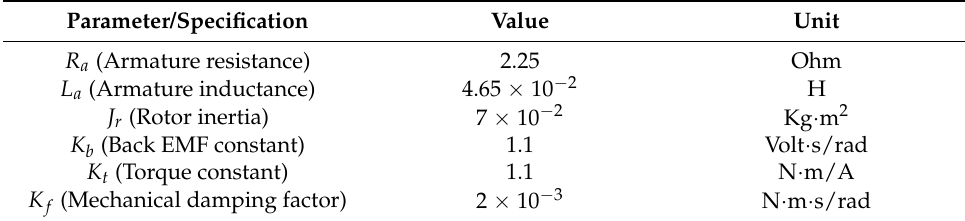
Table 6. DC motor parameters